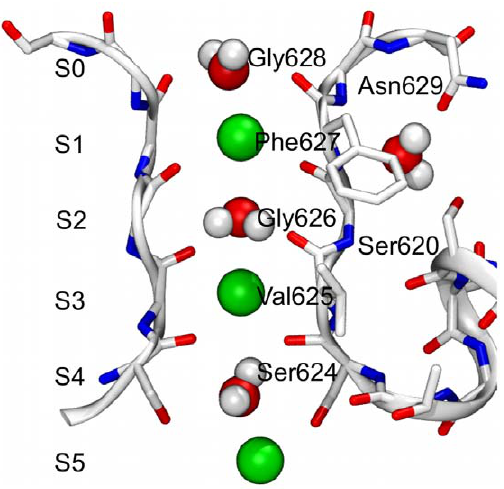
Figure 1. The Selectivity Filter of the hERG channel. The SF and the regions of the channel located in proximity of it are displayed as sticks and ribbons. For clarity, only two opposite subunits of the channel are shown. The depicted SF occupancy state (here referred to as S5[S3,S1]) involves three potassium ions and three water molecules (shown as van der Waals spheres). The additional water molecule placed behind the SF is also shown.